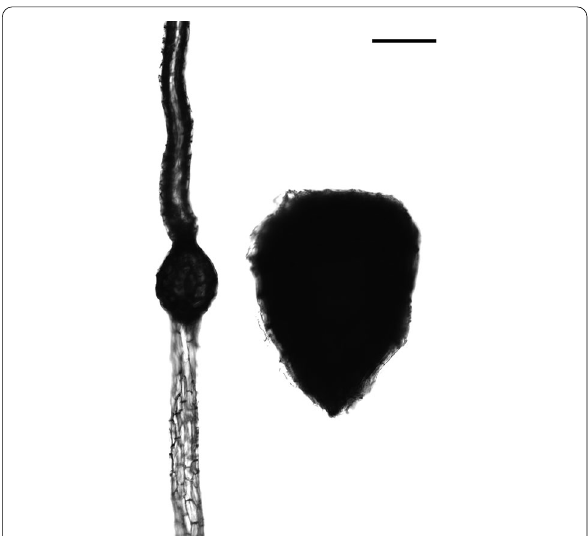
Fig. 2 Seed morphology of N. singapureana (right) and its sister species, N. veratrifolia (left). Bar